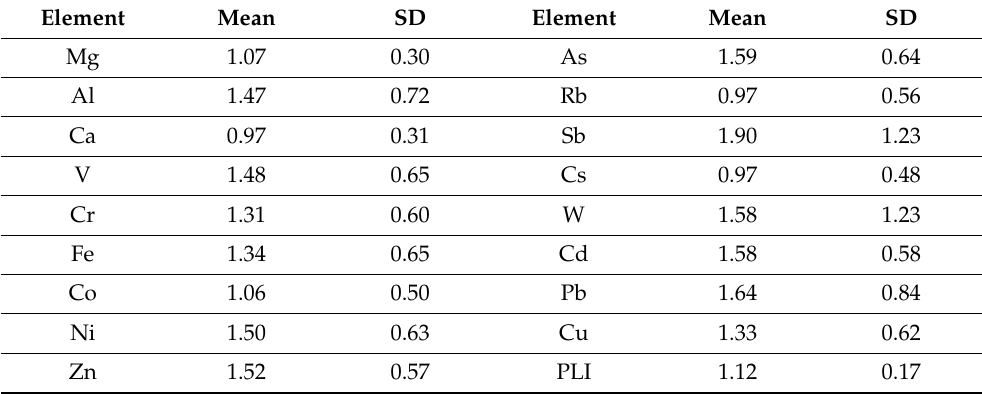
Table 5. Mean ± standard deviation values of Contamination factor and Pollution Load